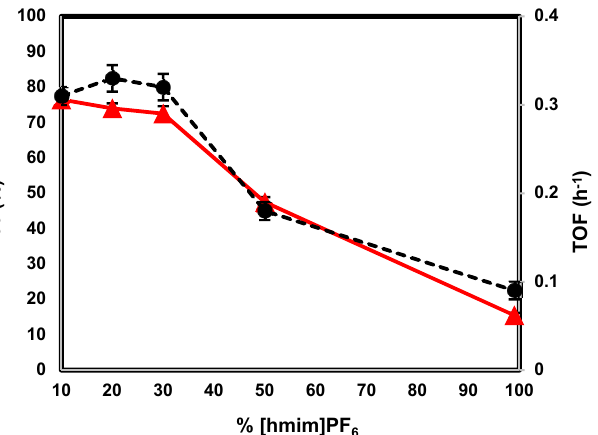
Figure 2. Effect of the [hmim]PF 6 amount in the TOF ( ● ) and the optical purity ( ▲ ) of ( S )- 3a for the thiourea II organocatalyzed addition of 1 to ethyl 2-oxo-4-phenylbutyrate ( 2a ) catalyzed in toluene at − 45 °C. Reported values are the mean of two replicates, with the uncertainties compounded from the TOF and optical purity data.